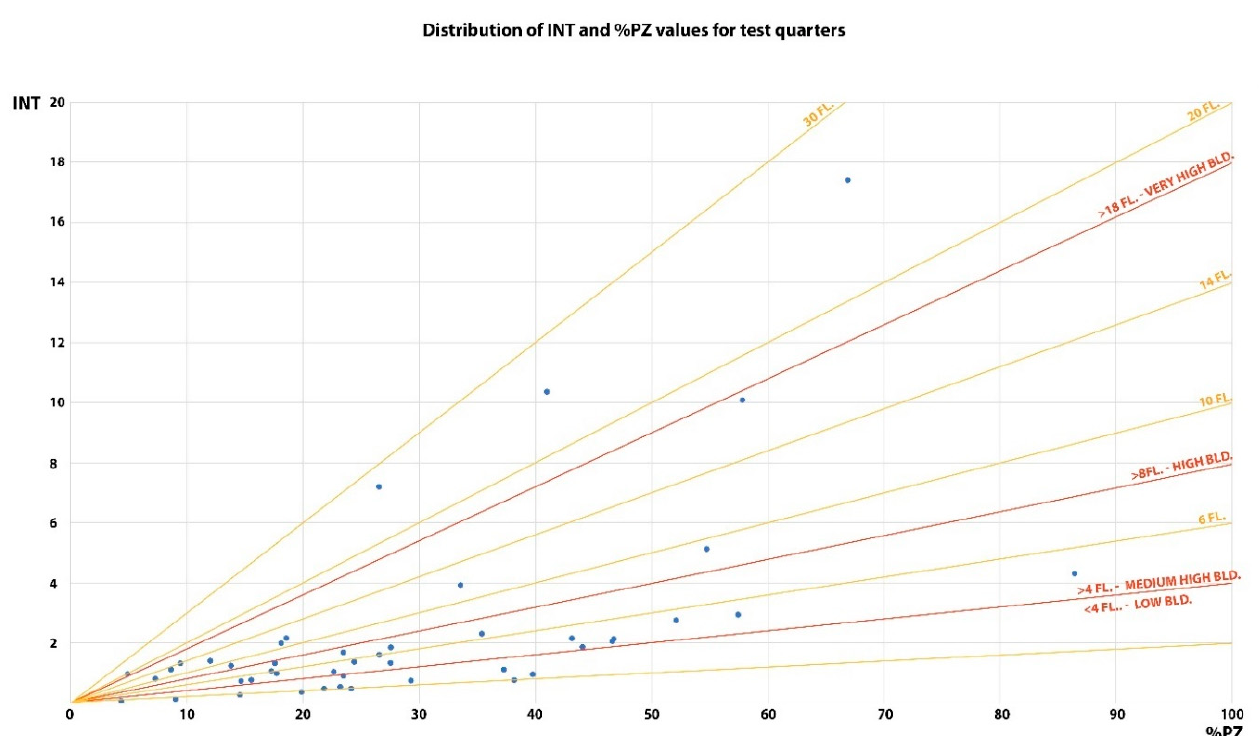
Figure 6. Distribution of INT and %PZ values for test quarters. Source: own study.